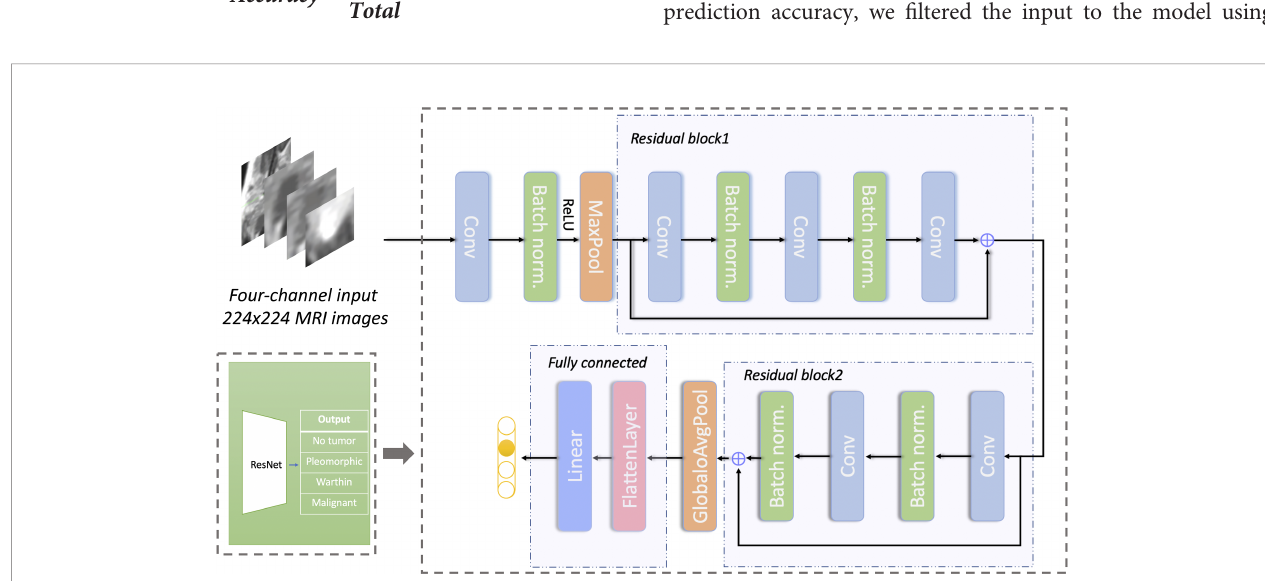
FIGURE 4 | Network structure for predicting different types of parotid gland tumors based on ResNet. The network has 2 residual blocks. Conv, convolutional layer; Batch norm, batch normalization; Maxpool, max-pooling layer; GlobaloAvgpool, global average pooling layer; Linear, linear